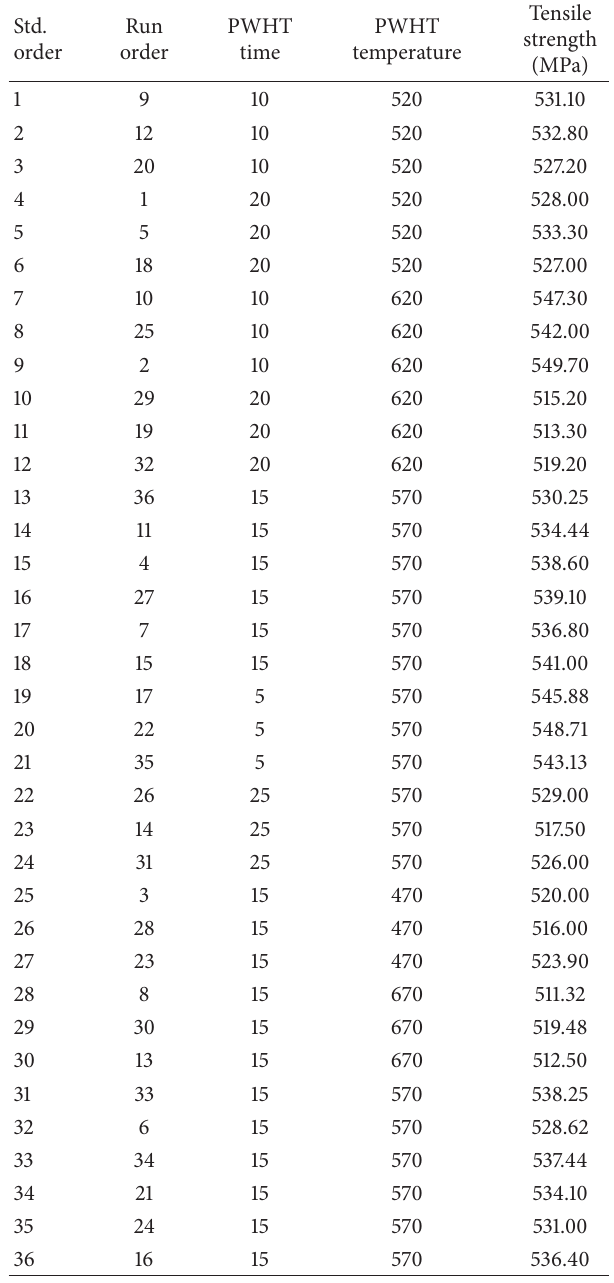
Table 2: Experimental factors for response surface methodology. Parameters